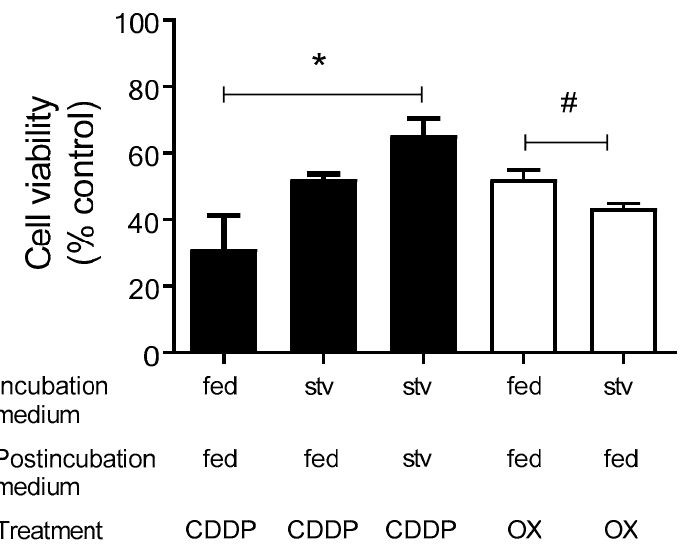
Figure 7. This figure shows the cytotoxic effects of 6 h incubation of HEK293-hOCT2 cells with 100 µM CDDP or OX under fed or starvation (stv) conditions followed by postincubation with DMEM (fed) or EBSS (stv, only for CDDP) for 48 h. Cell viability was measured using an MTT assay. Each bar shows the mean ± SEM of 6 replicates measured in three independent experiments. * and # show a statistically significant difference between the tested conditions ( p < 0.05, *ANOVA with Tukey post hoc test and # unpaired t -test,